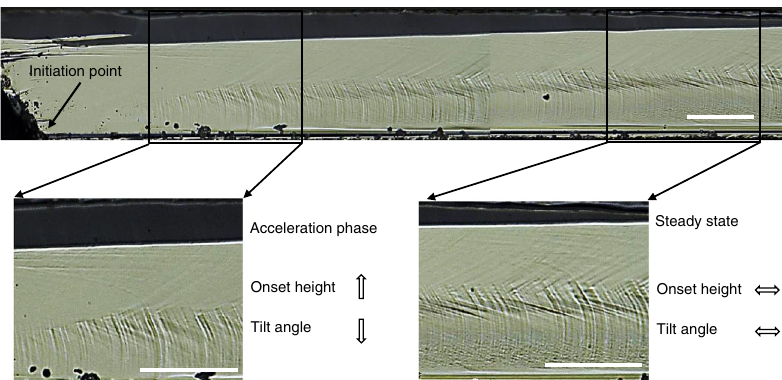
Fig. 4 Crack surface morphology nearby the crack initiation spot for the rapid crack (3600 m/s). SSMs appear about 150 μ m away from the initiation site and their position moves up in thickness as the crack velocity increases. Scale bars: 100 μ